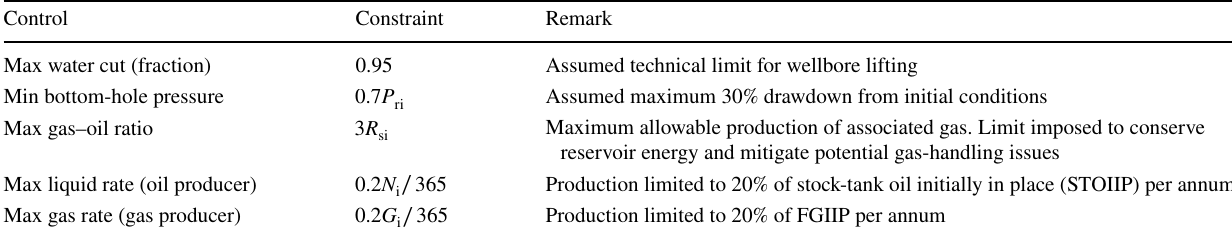
Table 3 An outline of development concepts examined Group Development concept